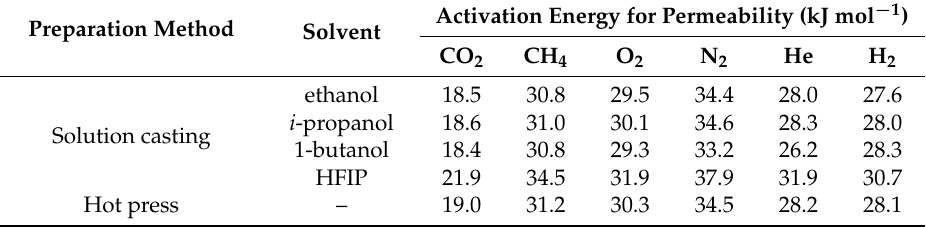
Table 8. Apparent activation energy for permeation ( Ep ), evaluated in the temperature range 15–55 ◦ C, for Pebax ® 2533 films (‘as